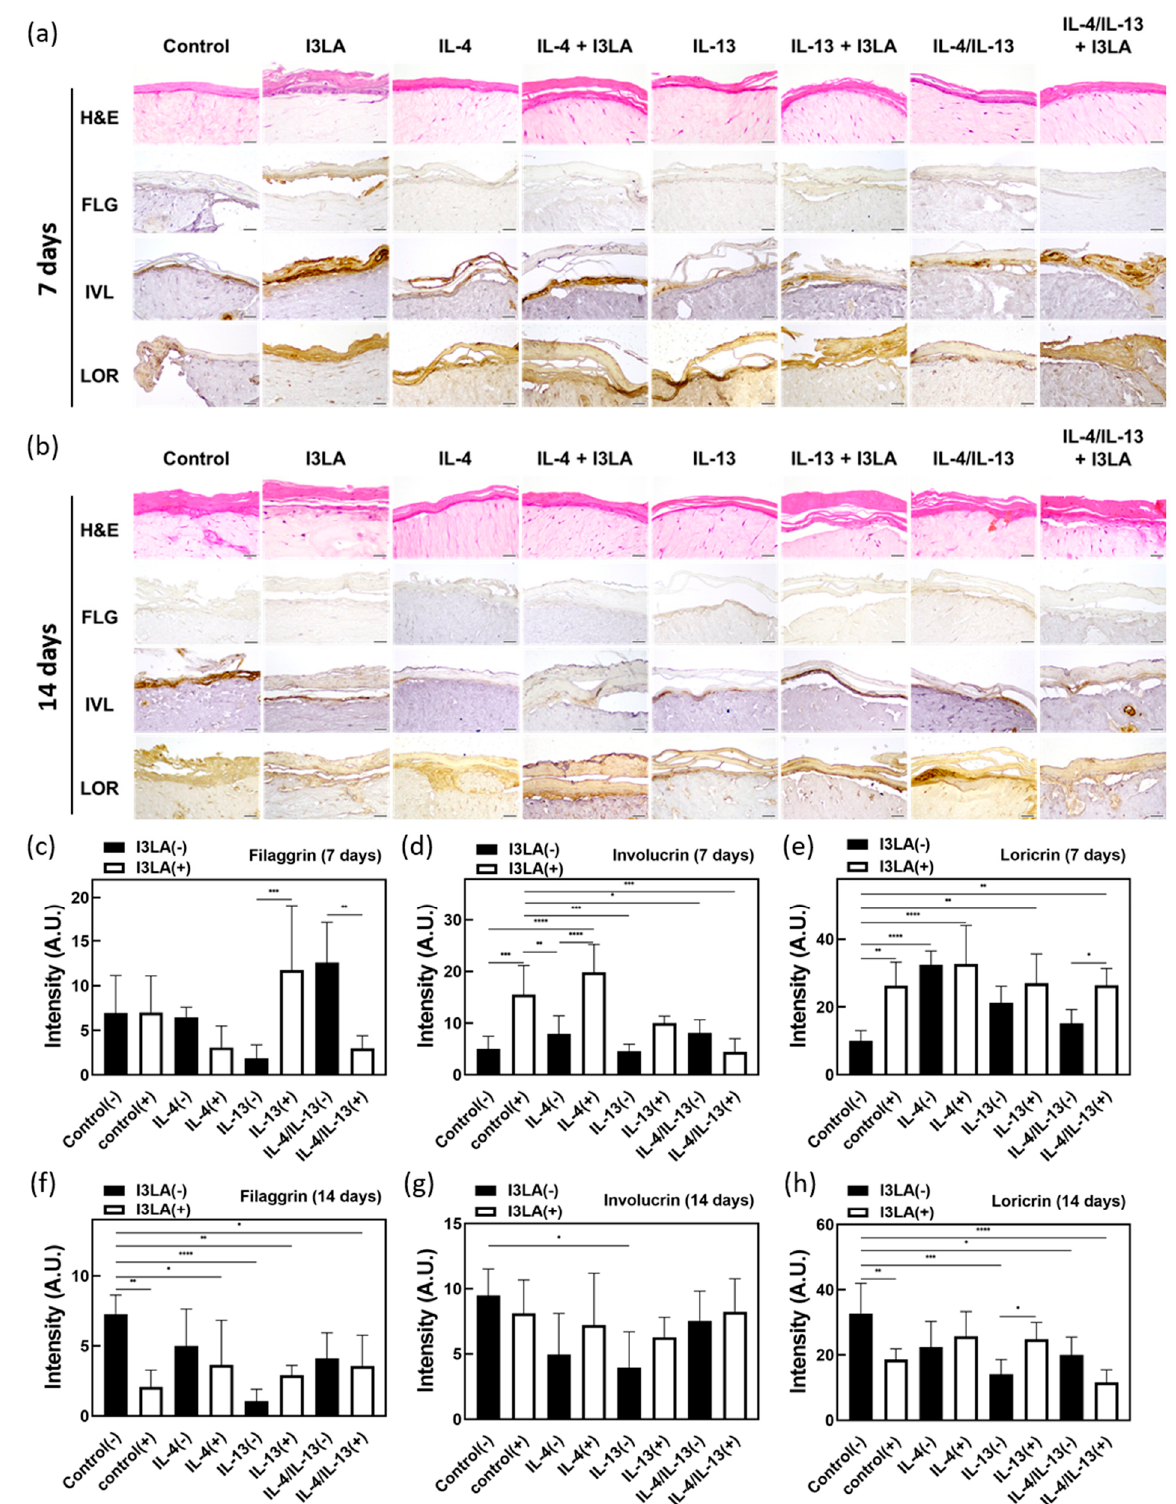
Figure 4. Images of H&E and IHC staining results for AD-HSEs stimulated with various concen- trations of IL-4 and IL-13 and cultured for 7 and 14 days, depending on the presence or absence of I3LA treatment, and graphs quantifying IHC DAB color development. ( a ) IHC staining